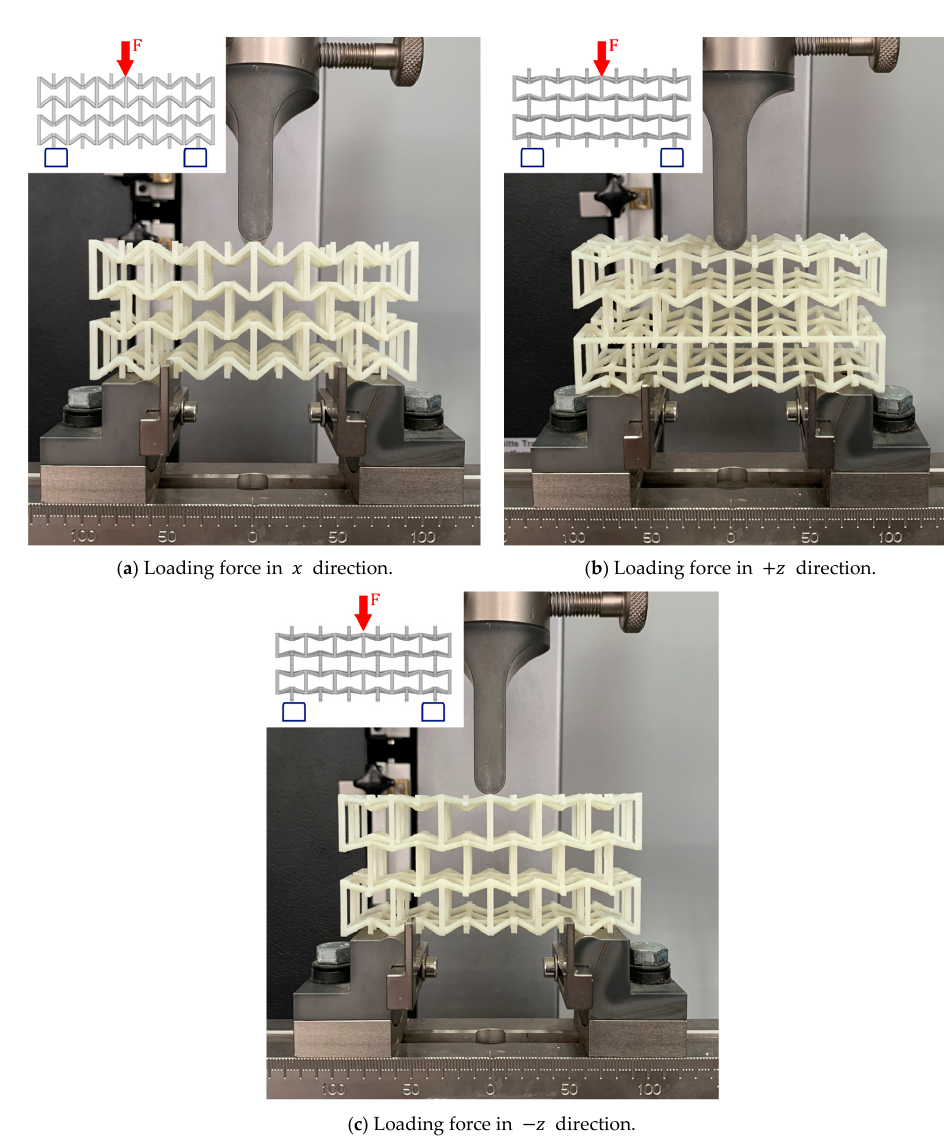
Figure 9. Quasi-static bending tests on the proposed macrostructure in the x , + z , and − z Figure 9. Quasi ‐ static bending tests on the proposed macrostructure in the 𝑥 , (cid:3397)𝑧 , and (cid:3398)𝑧 direc ‐ tion.